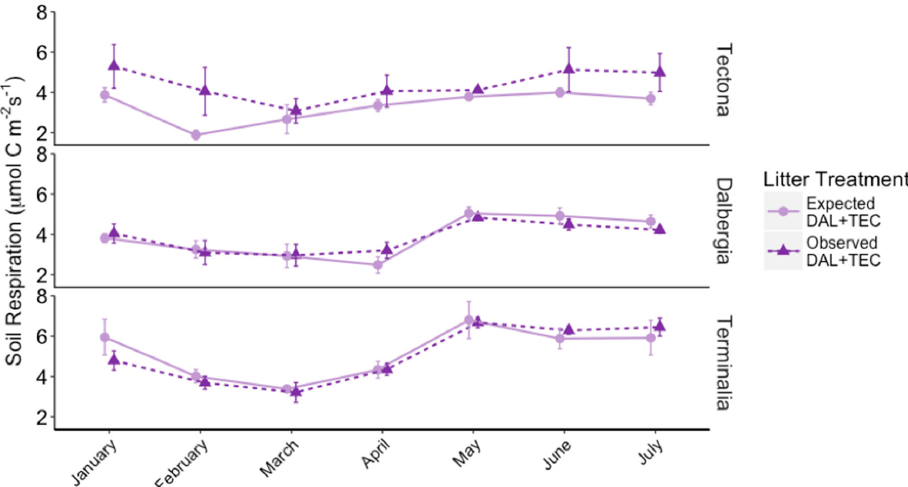
Figure 8. Non-additive effects of mixed litter from Tectona grandis (TEC) and Dalbergia retusa (DAL), showing expected soil respiration calculated as the mean respiration of the single-species litter treatments, and the observed respiration during seven months of decomposition in monoculture plantations of Tectona grandis, Dalbergia retusa and Terminalia amazonia as part of a litter decomposition experiment in Panama, Central America, showing means and standard errors for n = 5.